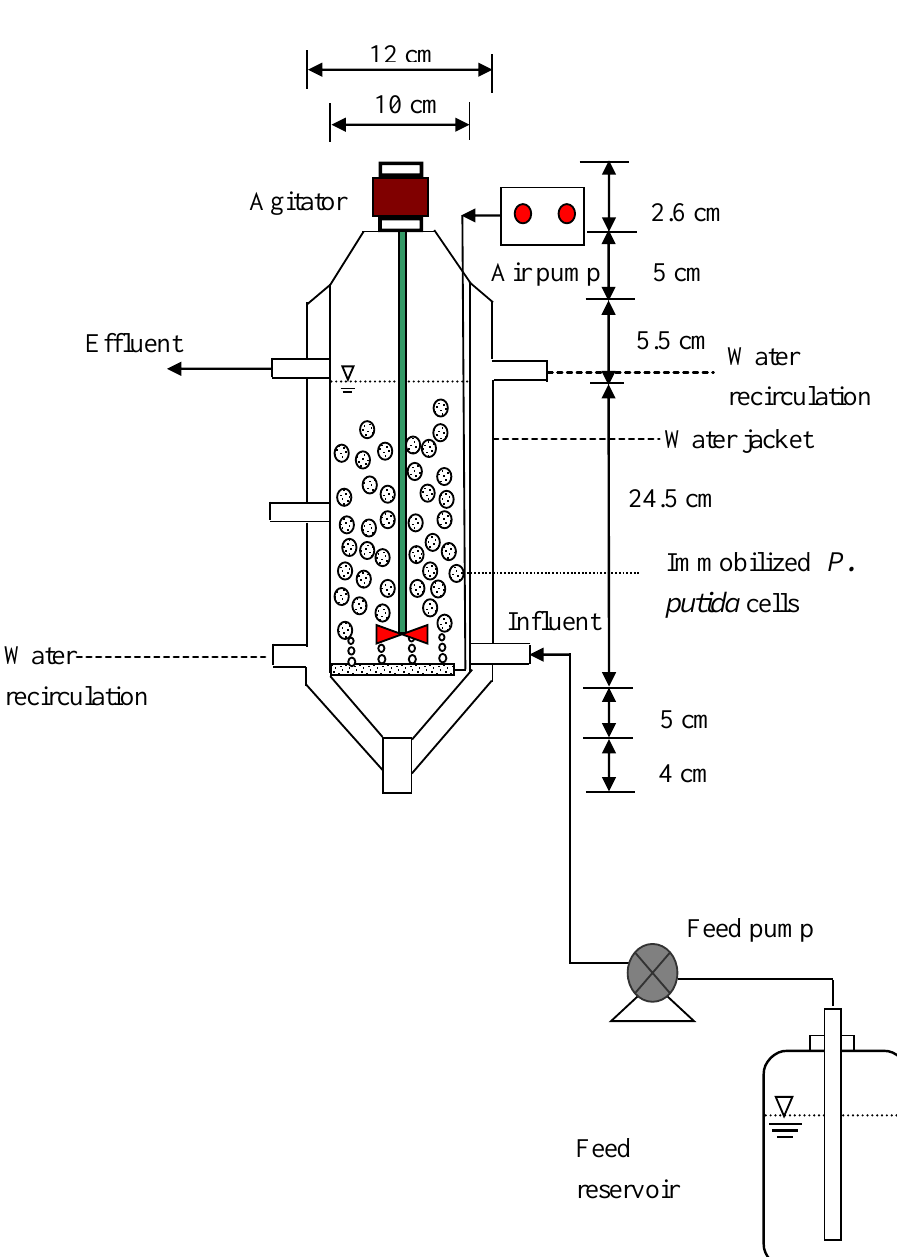
Figure 2. A continuous-flow immobilized cell reactor setup.